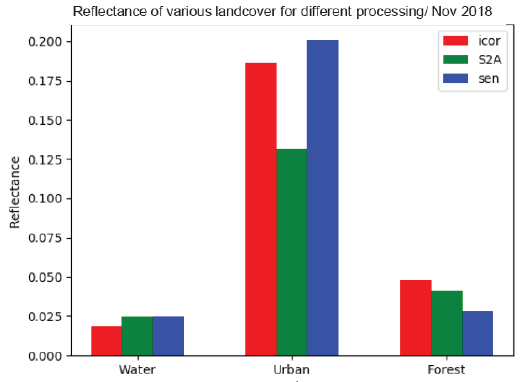
Figure 8. Histogram of pixel reflectance values for land